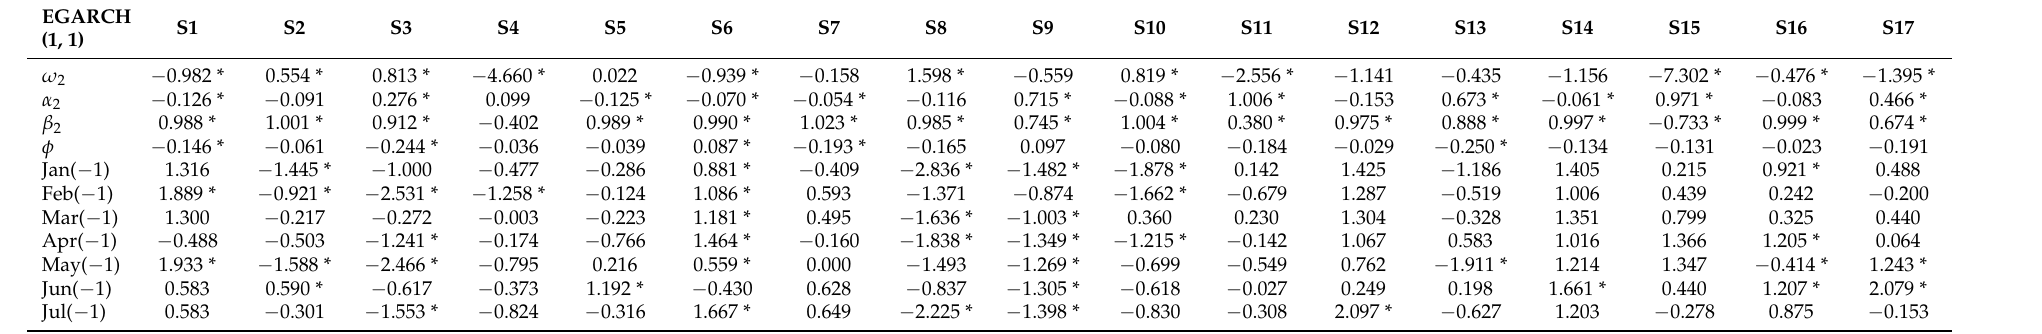
Table 6. EGARCH (1,1) conditional variance